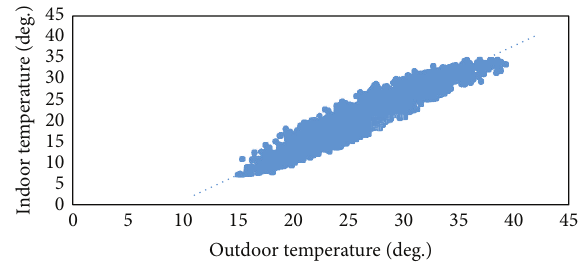
Figure 8: Variation of indoor and outdoor temperatures.